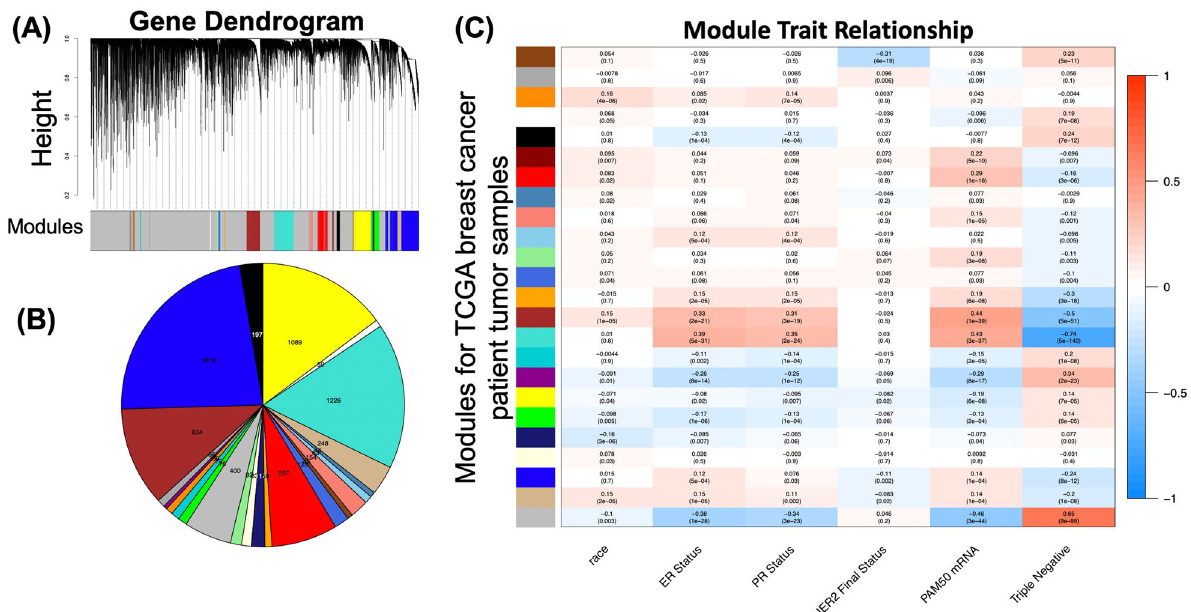
Figure 1. Network construction and module detection for Weighted Gene Co-expression Network Analysis (WGCNA) of Breast Invasive Carcinoma RNA-seq samples from TCGA database. ( A ) Gene dendrogram of clustered gene dissimilarity, based on consensus topological overlap, with corresponding gene module colors of the TCGA breast invasive carcinoma RNA-seq dataset from n = 824 tumor patient samples, each with 20,253 genes analyzed in one block. ( B ) Number of genes in each module identified from WGCNA. The modules containing the greatest number of genes are the blue, turquoise, yellow, and brown modules. ( C ) Module-trait associations for tumor only samples (excluding normal samples) from the cohort. The corresponding p -value for the correlation of the module with the clinical parameter is in parenthesis. The grid is color-coded by correlation according to the color